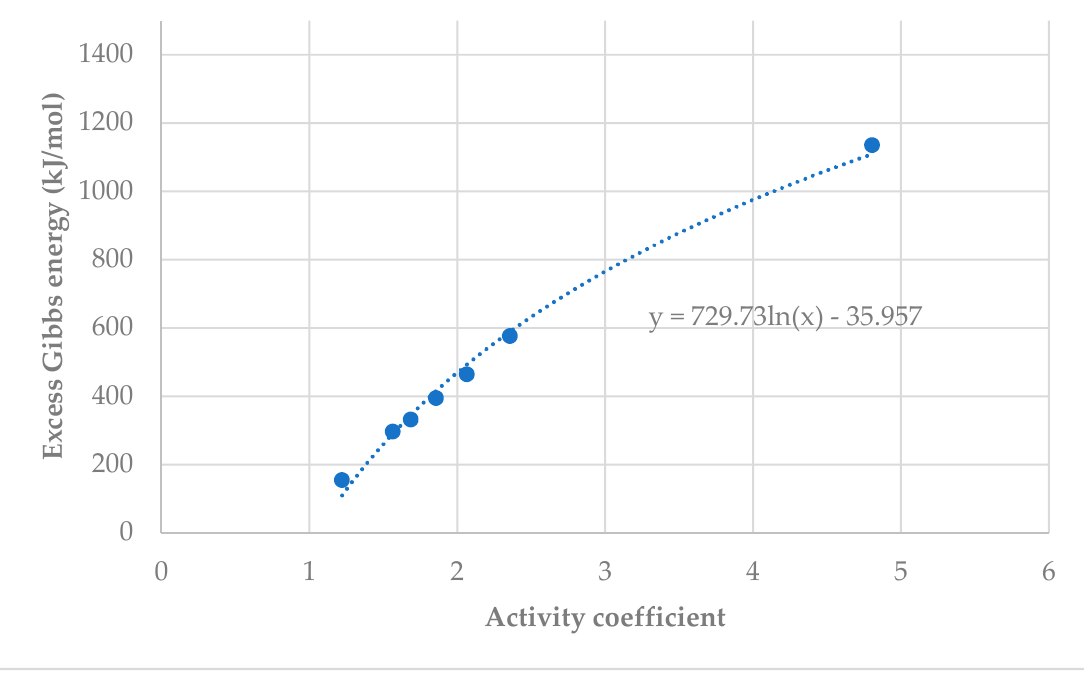
Figure 13. Relationship between Excess Gibbs Energy and activity coefficient of fructose .